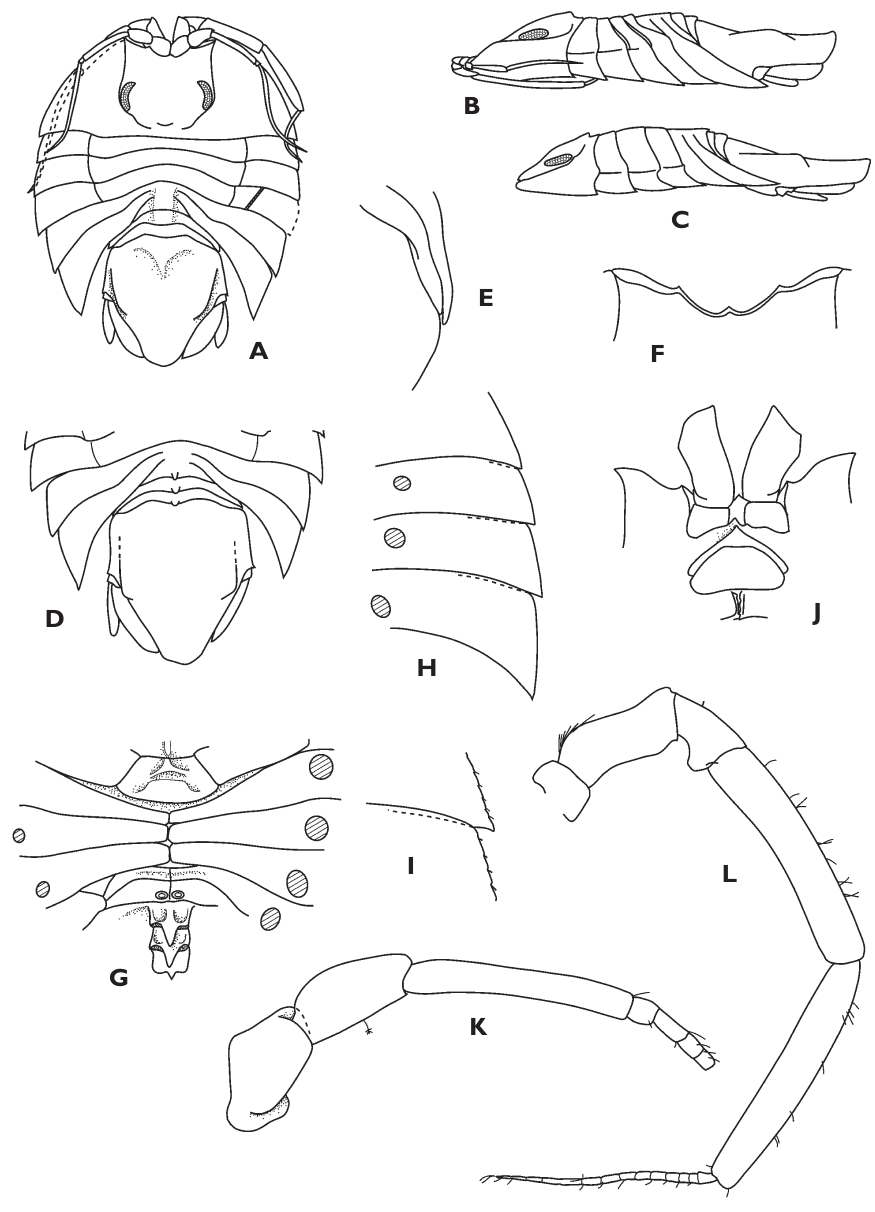
Figure 1. Heteroserolis pellucida sp. n. Holotype, except where indicated. A dorsal view B lateral view C lateral view ( ♀ 14.8 mm, Is.6017) D pleon and pleotelson, dorsal view ( ♀ 14.8 mm, Is.6017) E pleonites F head, anterior margin G sternites and ventral pleonites H ventral coxae 2–4 I ventral join pereonites 2 and 3 J frons; ♂ 10.5 mm, Is.6017 K antennule L